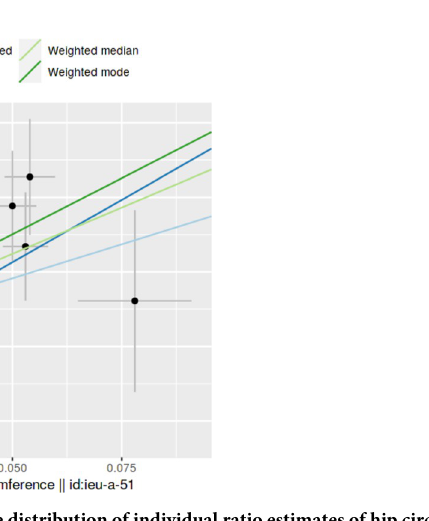
Fig 4. Scatter plot illustrating the distribution of individual ratio estimates of hip circumference with polycystic ovarian syndrome as the outcome. Trend lines from the four different two-sample Mendelian randomization methods employed indicating the positive causal associations, are also included in each scatter plot.